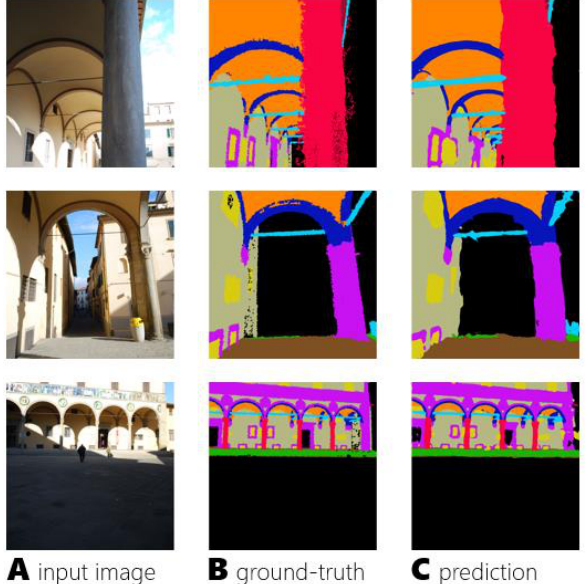
Figure 1: DeepLabv3+ results on the test set (Test 1): A) input image, B) ground-truth, C) prediction.